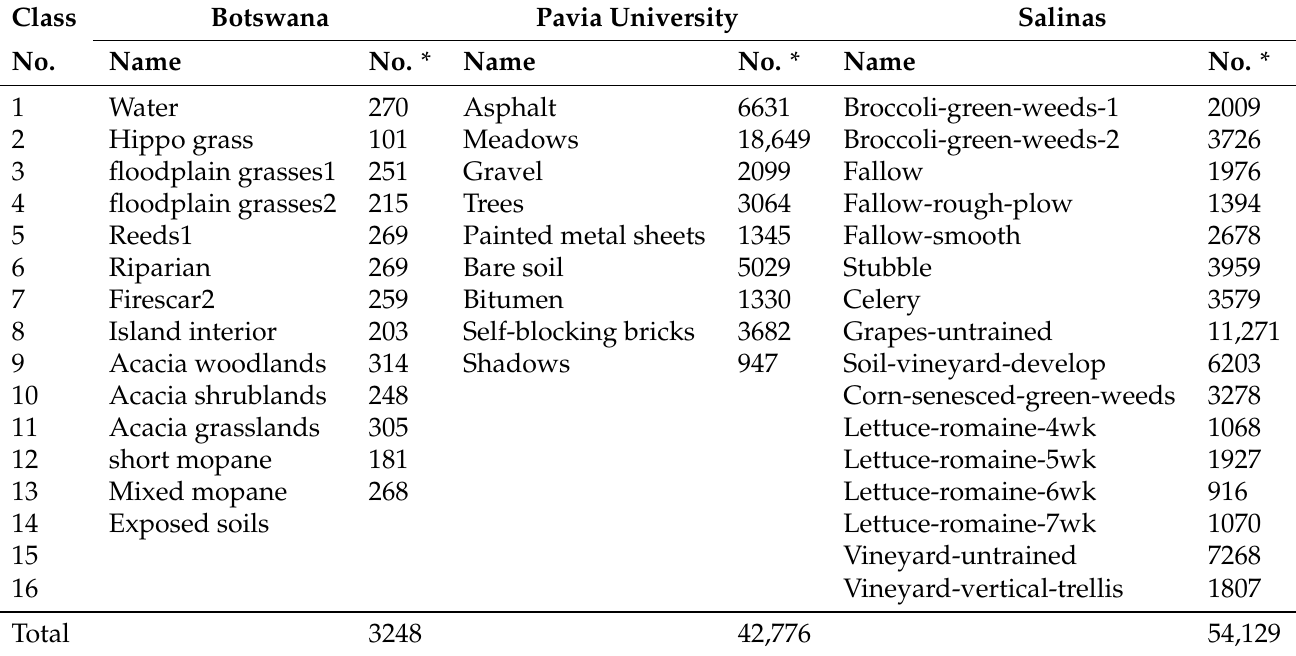
Table 1. Description of the hyperspectral remote sensing